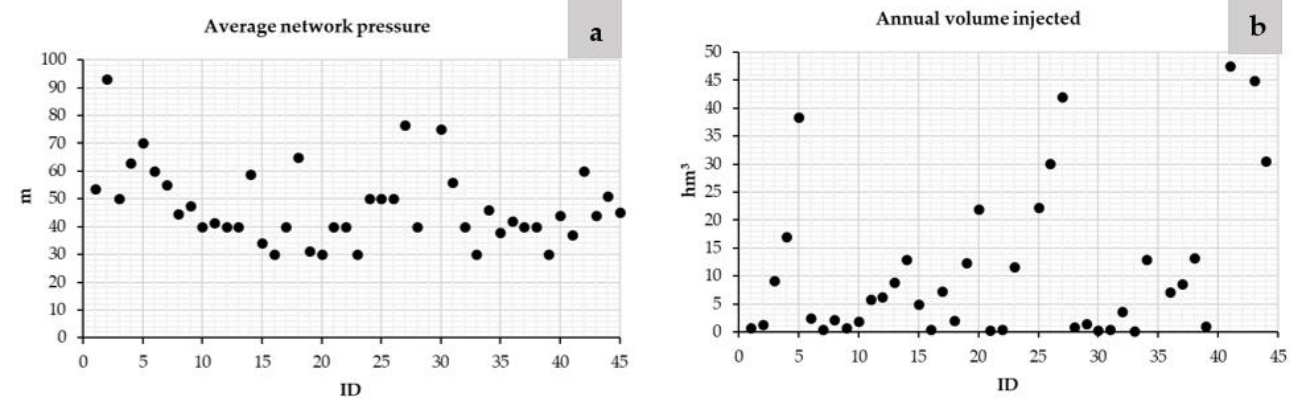
Figure 3. Average pressure ( a ) and annual flow injected into the network ( b ). The average pressure of each case study was related to the percentage of leaks and the volumetric efficiency of the system. The ratio between the average pressure and the leakage percentage is shown in Figure 4a. The values are between 50 and 500, being the average equal to 243. Figure 4b shows the relationship between the average pressure of the network and the volumetric performance. This ratio shows values between 40 and 200, being the average value equal to 78 m.w.c.